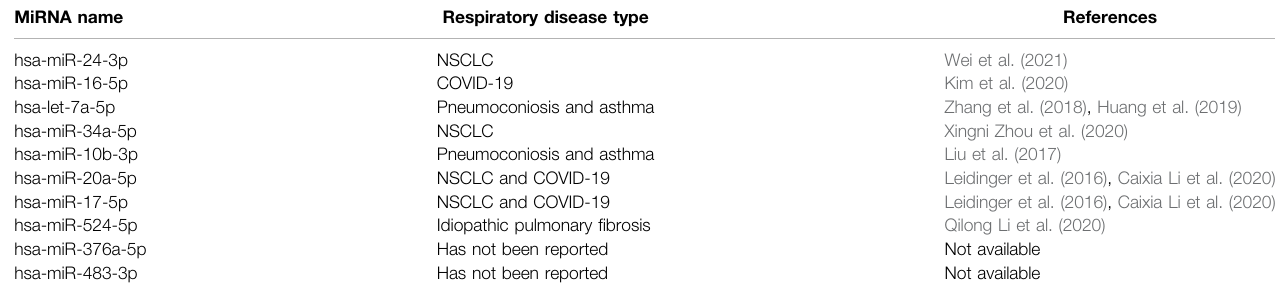
TABLE 4 | Top 10 miRNAs involved in various respiratory